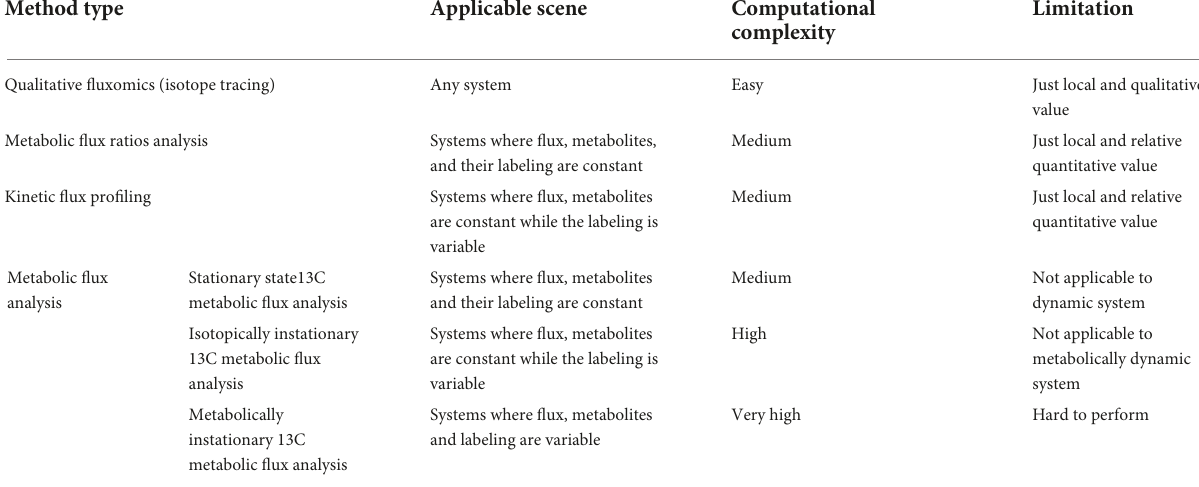
TABLE 1 Comparison of different fluxomics